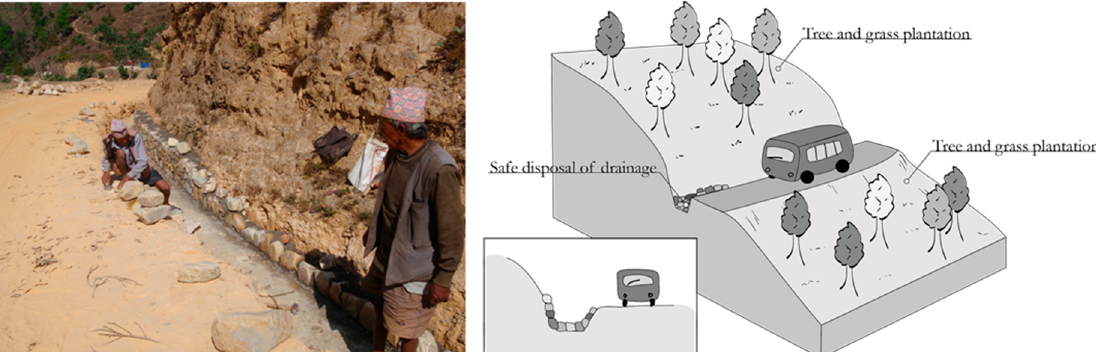
Figure 8. ( Left ) Example of roadside drainage construction in Bhatkhola demonstration site in Syangja; ( Right ) schematic illustrations of drainage works along the road [57].